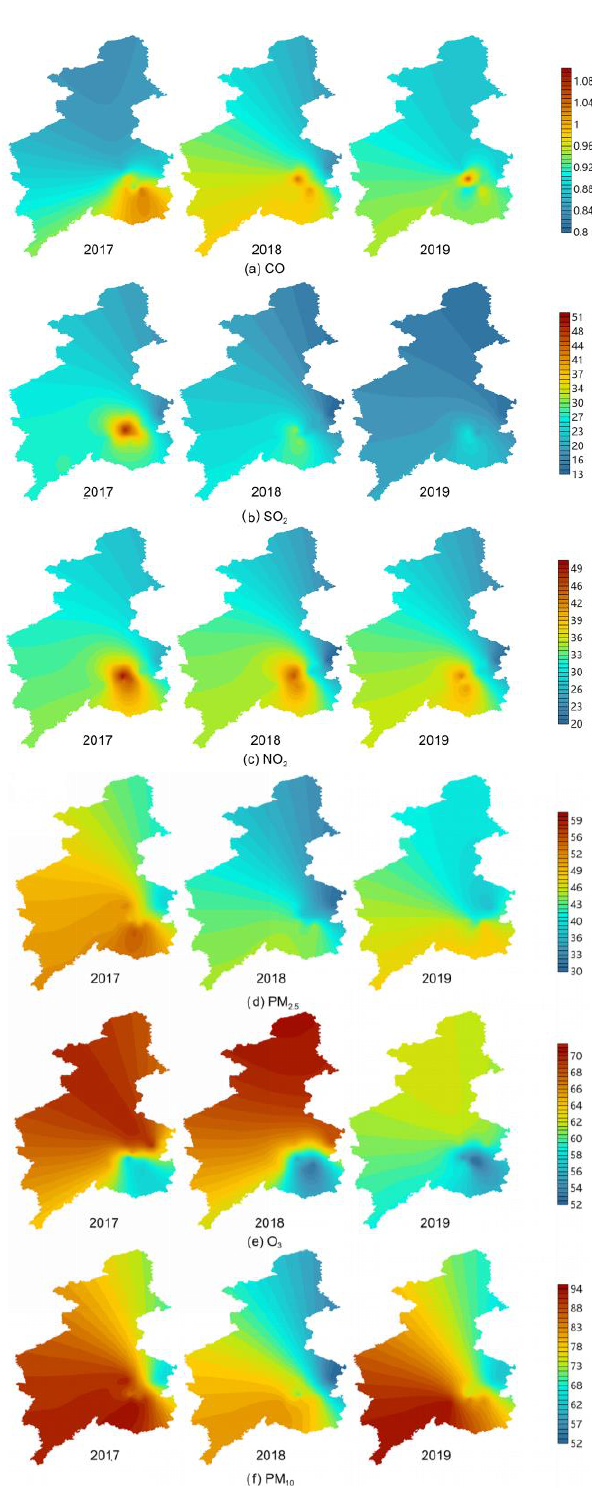
Figure 2. Spatial distributions of annual average mass concentrations of the six pollutants from 2017 to 2019: ( a ) CO, ( b ) SO 2 , ( c ) NO 2 , ( d ) PM 2.5 , ( e ) O 3 , ( f ) PM 10 (CO unit: mg · m − 3 ; other pollutant units: µ g · m − 3 ).